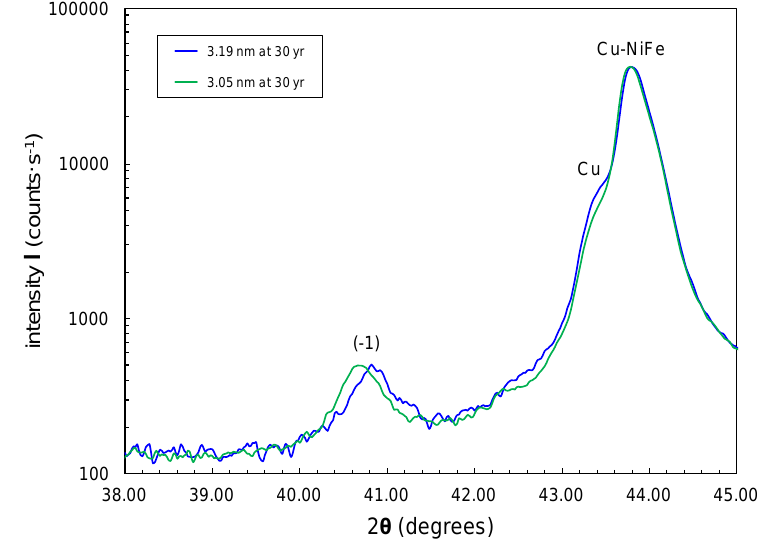
Figure 2. The initial and final composition wavelength values are listed in Table 1. The slope of the dot-dash curve fit is 0.978 in Figure 2, with a correlation coefficient of 0.972. There is no significant change (i.e., <2%) in composition wavelength. However, a shift towards a 3-nm final spacing is found for initial wavelengths between 2 and 4 nm.